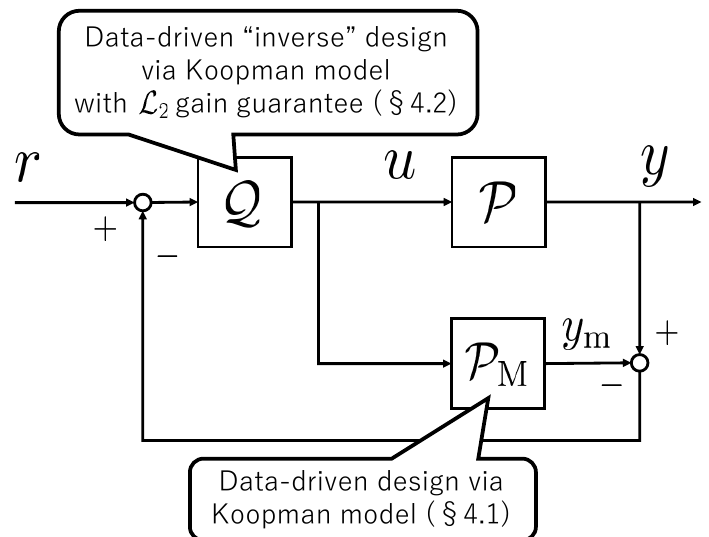
Figure 4. IMC-based control system and organization of Section